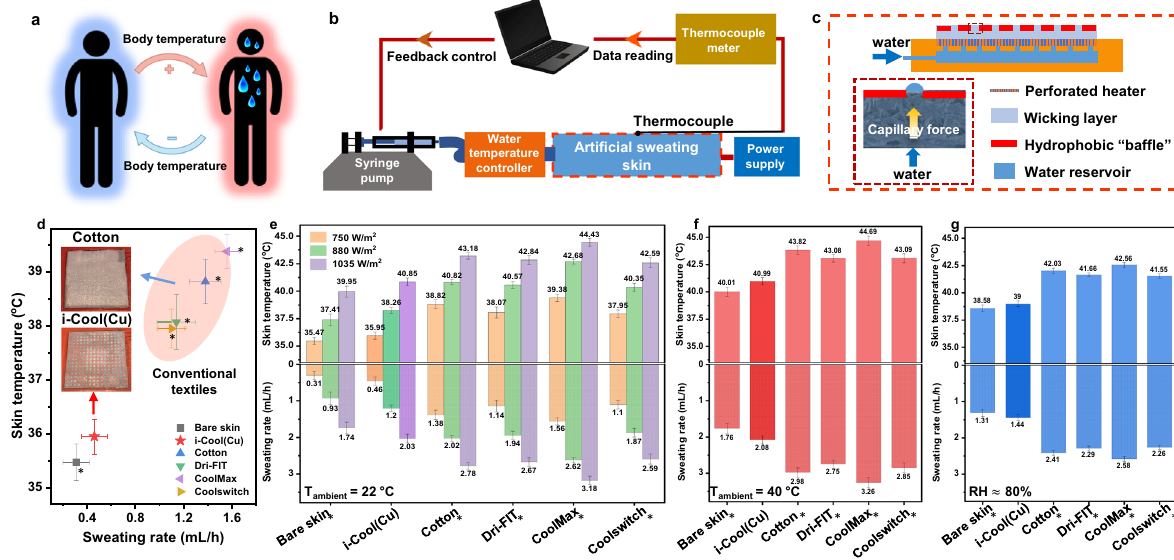
Fig. 4 Arti fi cial sweating skin platform with feedback control loop and measurements on it. a , Schematic of human body temperature self-regulation mechanism. When body temperature increases, human body perspires to cool down its own temperature, which leads to reduction or suspension of perspiration in reverse. b , Schematic of the arti fi cial sweating skin platform with feedback control loop simulating human body temperature self-regulation mechanism. c , Schematic of the detailed structure of the arti fi cial sweating skin. The schematic in the red dash box shows the working mechanism of the modi fi ed Janus-type wicking layer which realizes uniform sweating mimicking human skin sweating scenario. d , Measurement results of skin temperature and sweating rate for bare skin, i-Cool (Cu) and commercial textiles (skin power density: 750 W/m 2 , ambient temperature: 22 °C). Insets show the photographs of i-Cool (Cu) and cotton after one-hour stabilization during the tests. Asterisk, Statistical signi fi cance of skin temperature and sweating rate between the i-Cool (Cu) and other textiles, Welch ’ s t -test p < 0.001. e , Measurement results of skin temperature and sweating rate for bare skin, i-Cool (Cu) and other conventional textiles under different skin power densities. Asterisk, Statistical signi fi cance of skin temperature and sweating rate between the i-Cool (Cu) and other textiles at 750 W/m 2 , 880 W/m 2 and 1035 W/m 2 , Welch ’ s t -test p < 0.001. f , Measured skin temperature and sweating rate at high ambient temperature (40 °C). 750 W/m 2 power density was applied. Asterisk, Statistical signi fi cance of skin temperature and sweating rate between the i-Cool (Cu) and other textiles, Welch ’ s t -test p < 0.001. g , Measured skin temperature and sweating rate in high relative humidity ambient (~80%). Asterisk, Statistical signi fi cance of skin temperature and sweating rate between the i-Cool (Cu) and other textiles, Welch ’ s t -test p < 0.001. All the error bars represent standard deviation of measured